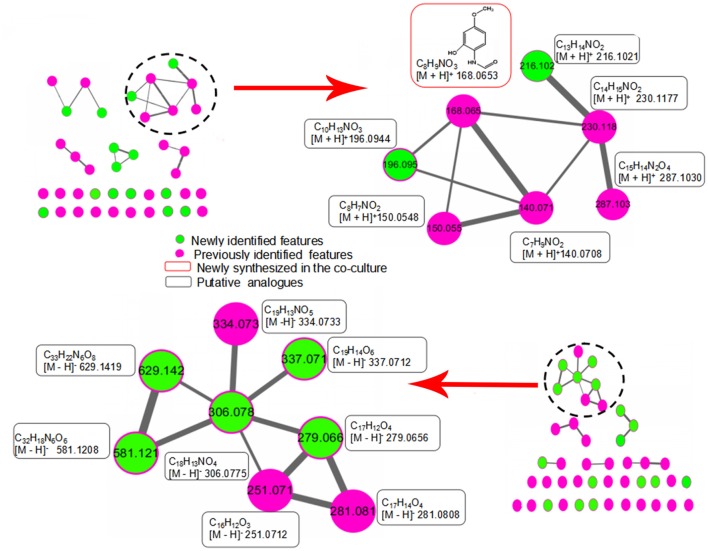
Molecular network analysis of newly discovered features in the co-culture. The green nodes represent parent ions of newly identified features and purple nodes are the previous features, and the thickness of the edges between nodes indicates the degree of similarity between their respective MS/MS spectra. Upper part shows a constructed subnetwork to dereplicate m/z 196.0944 and 216.1021. Lower part shows five newly identified features (m/z 279.0656, 306.0775, 337.0712, 581.1208, 629.1419) and three previous features (m/z 251.0712, 281.0808 and 334.0733) that clustered together.